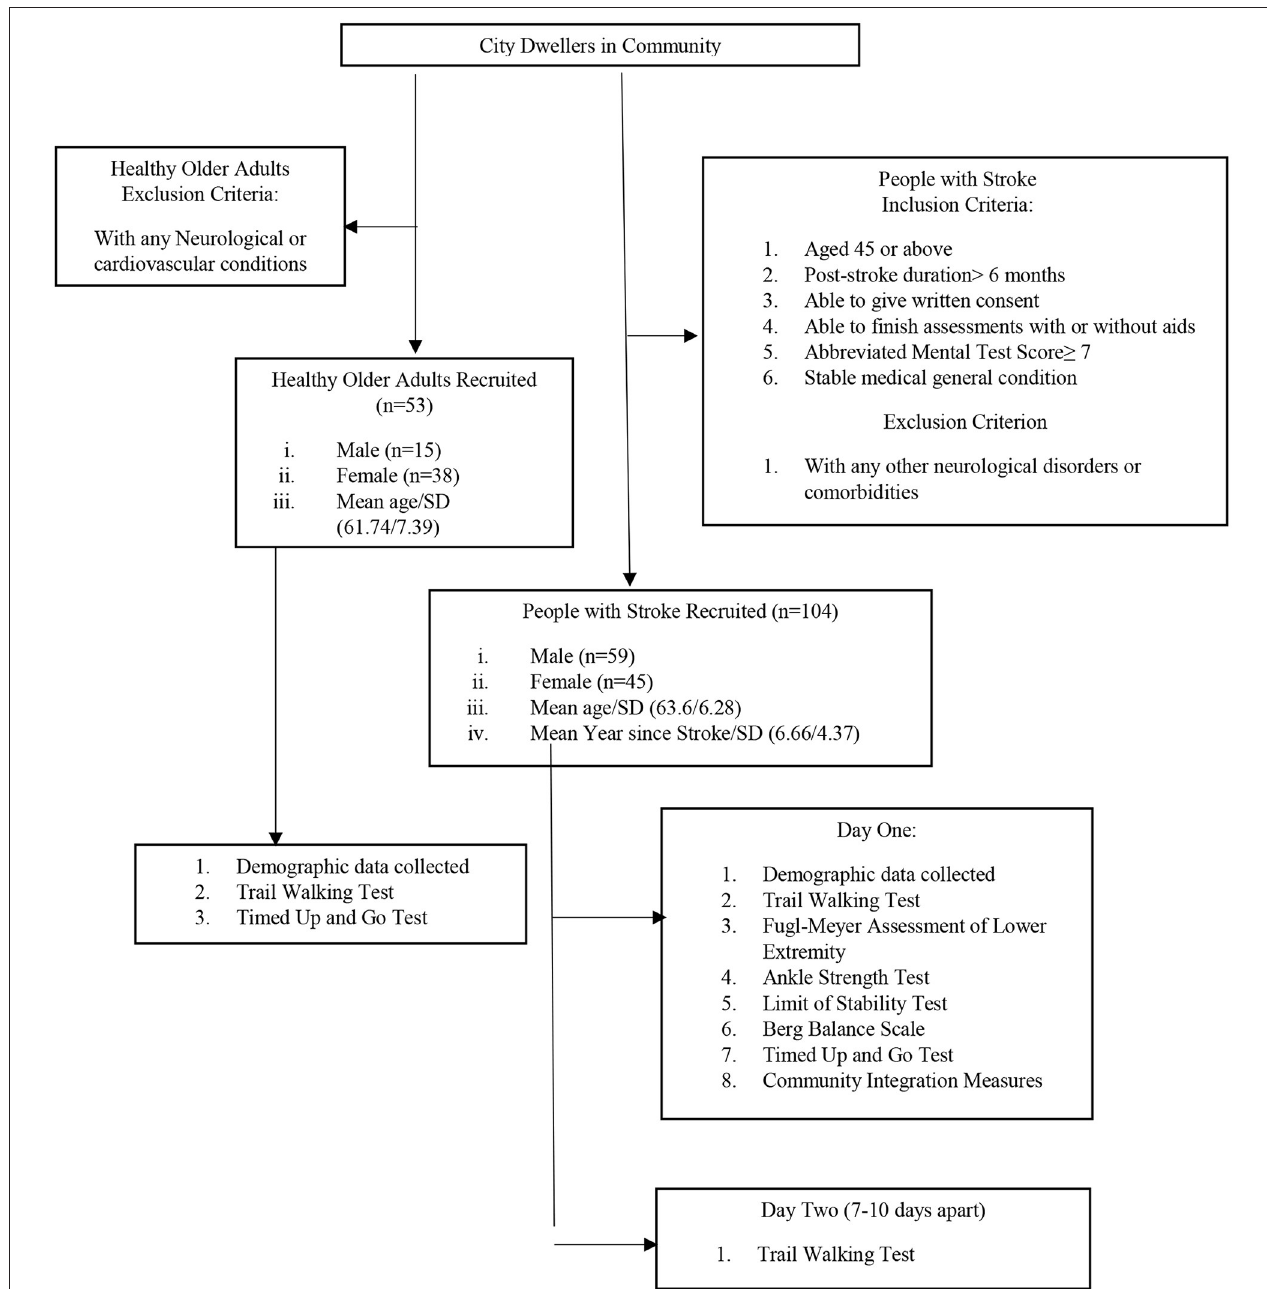
FIGURE 1 | Flowchart of the